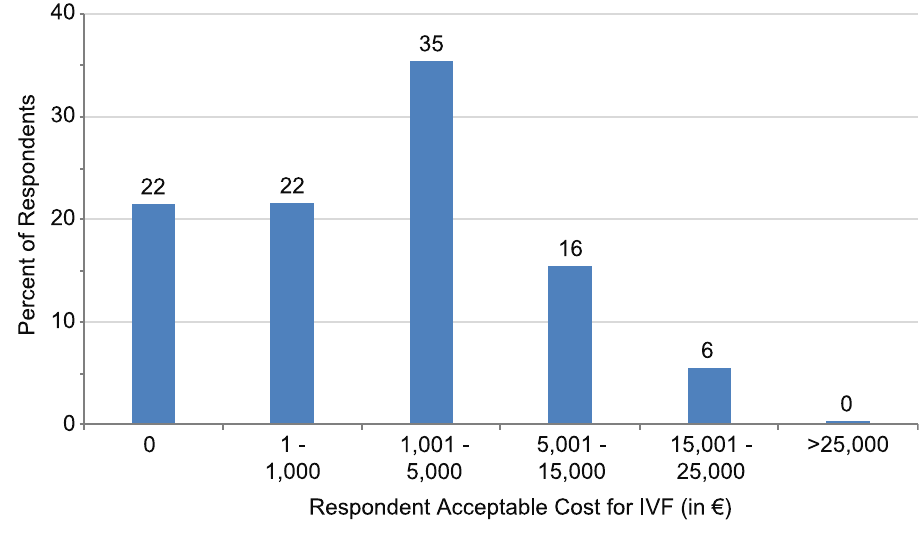
Fig 4. Acceptable cost for IVF (in € ). Mean acceptable cost: 5,400 €